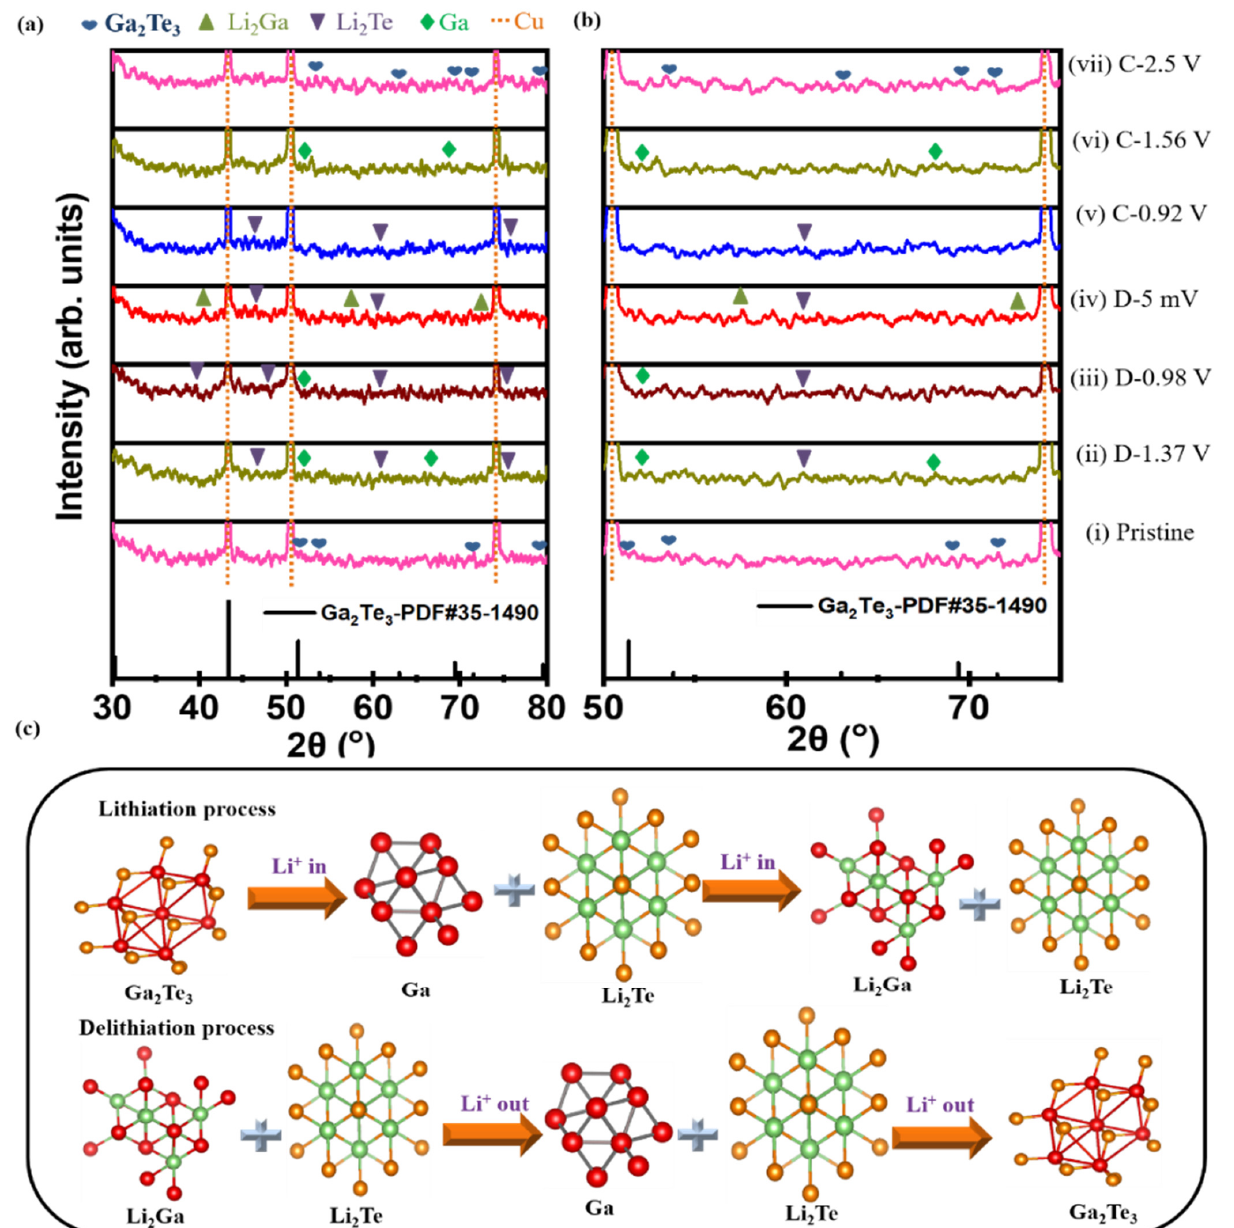
Figure 5. ( a , b ) Ex situ XRD patterns obtained at selected cutoff potentials in the initial dis- charge/charge process, and ( c ) schematics of phase change of Ga 2 Te 3 -TiO 2 -C (10%) electrode during cycling.